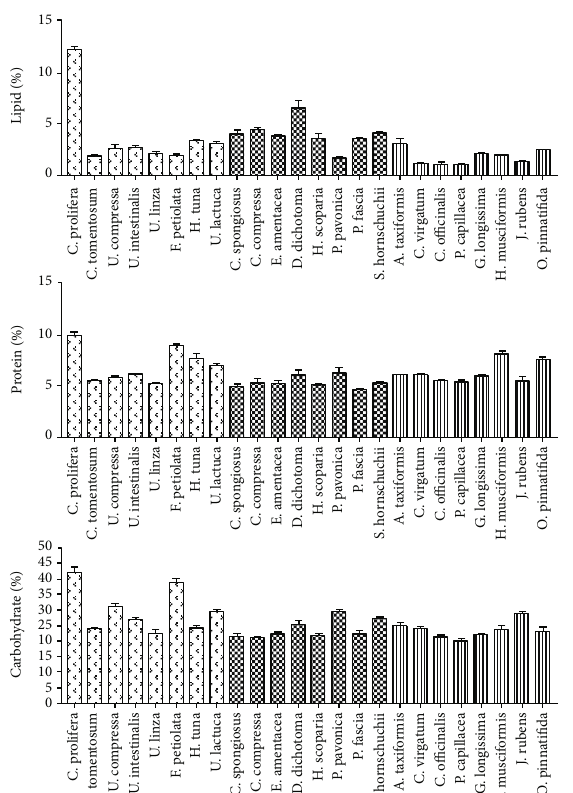
Figure 4: Proximate composition of vitamins, expressed as μ g/g dw of seaweeds collected from the Tripoli coastline. dw: dry